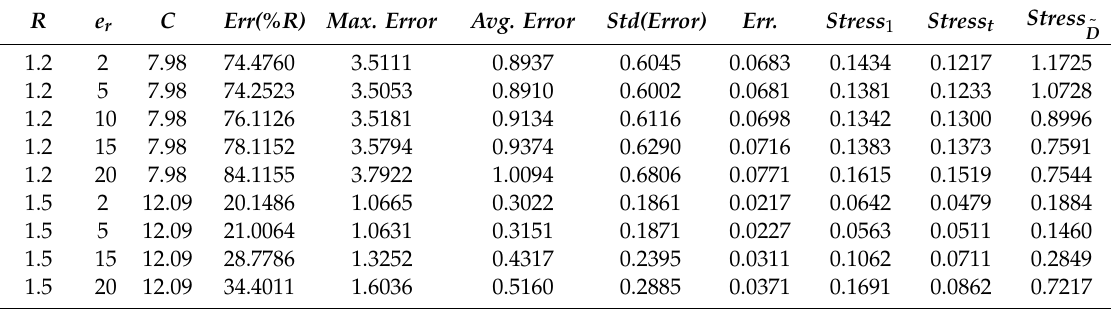
Table 2. MDS-MAP(D) Monte-Carlo simulations for 200 nodes randomly distributed in a 10r · 10r grid. Three anchors nodes, di ff erent noise levels in the estimated pairwise distances ( e r ) .